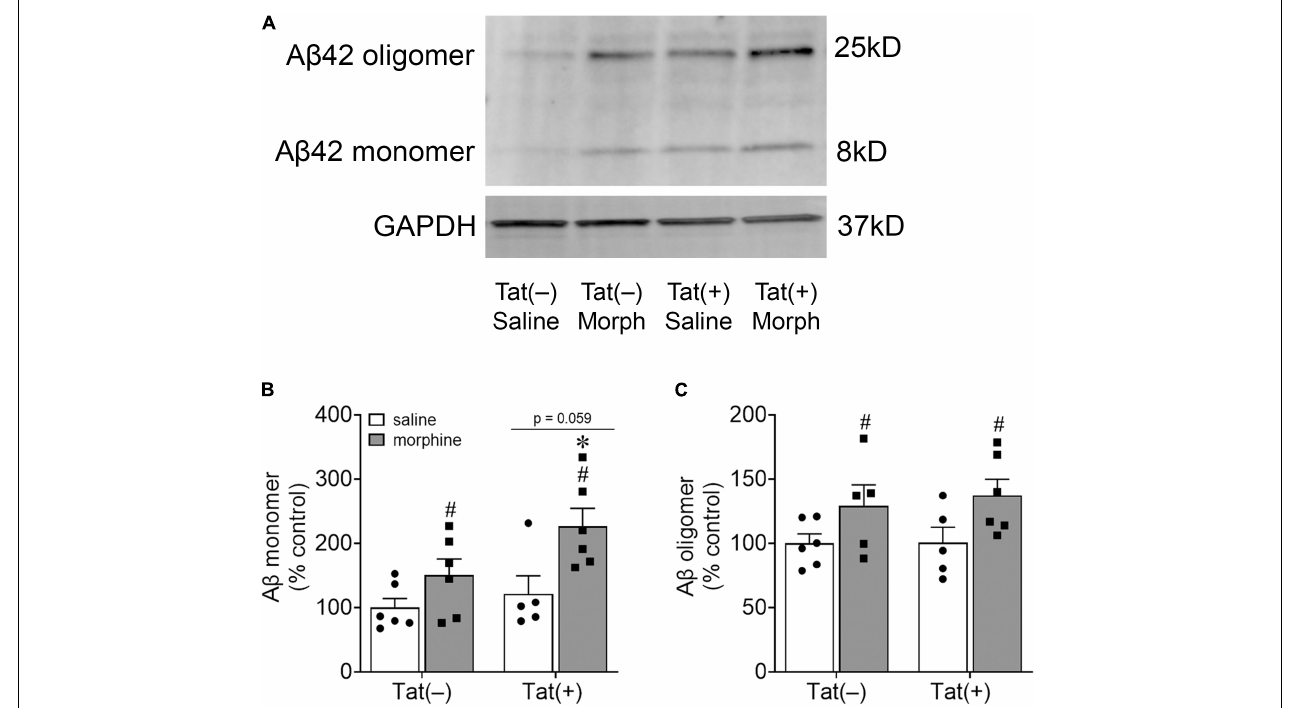
FIGURE 4 | Morphine increased amygdalar levels of amyloid- β . Representative images of amyloid- β (A β ) monomer and oligomer immunoblots within the amygdala of Tat-tg mice that received DOX for 8 weeks and ramped doses of morphine during the final 2 weeks of the experiment (A) . A main effect indicated that morphine exposure increased A β monomer levels in the amygdala, while Tat tended to increase A β monomer levels ( p = 0.059) (B) . Pairwise comparisons suggest that this effect was partially driven by the Tat(+) mice administered morphine (B) . Morphine, but not Tat, exposure also increased amygdalar A β oligomer levels (C) . ∗ p < 0.05, pairwise comparison difference from Tat(+)/saline; # p < 0.05, main effect of